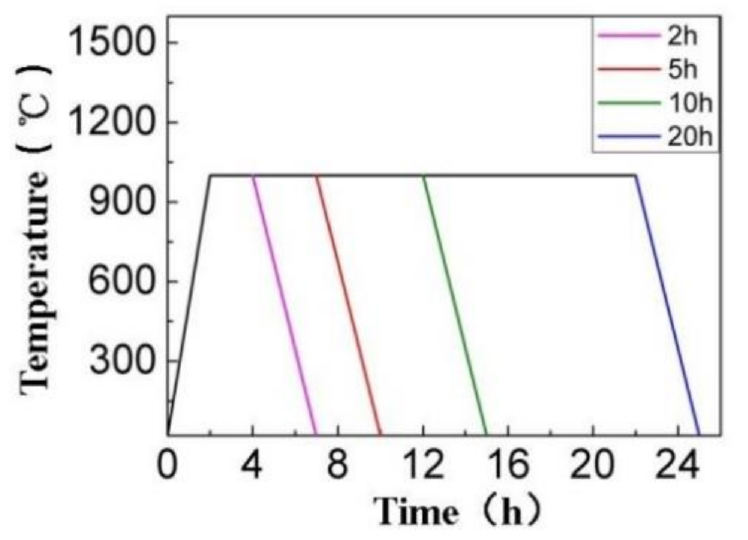
Figure 3. Temperature profile during thermal